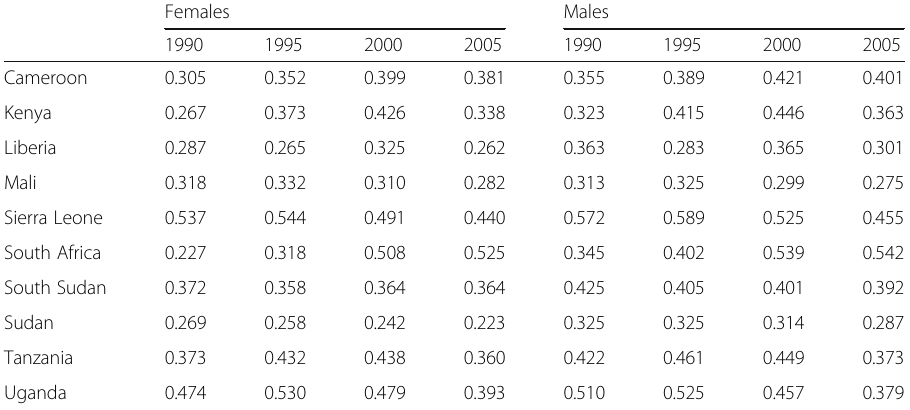
Table 6 United Nations Population Division adult mortality estimates ( 45 q 15 ) by country and sex